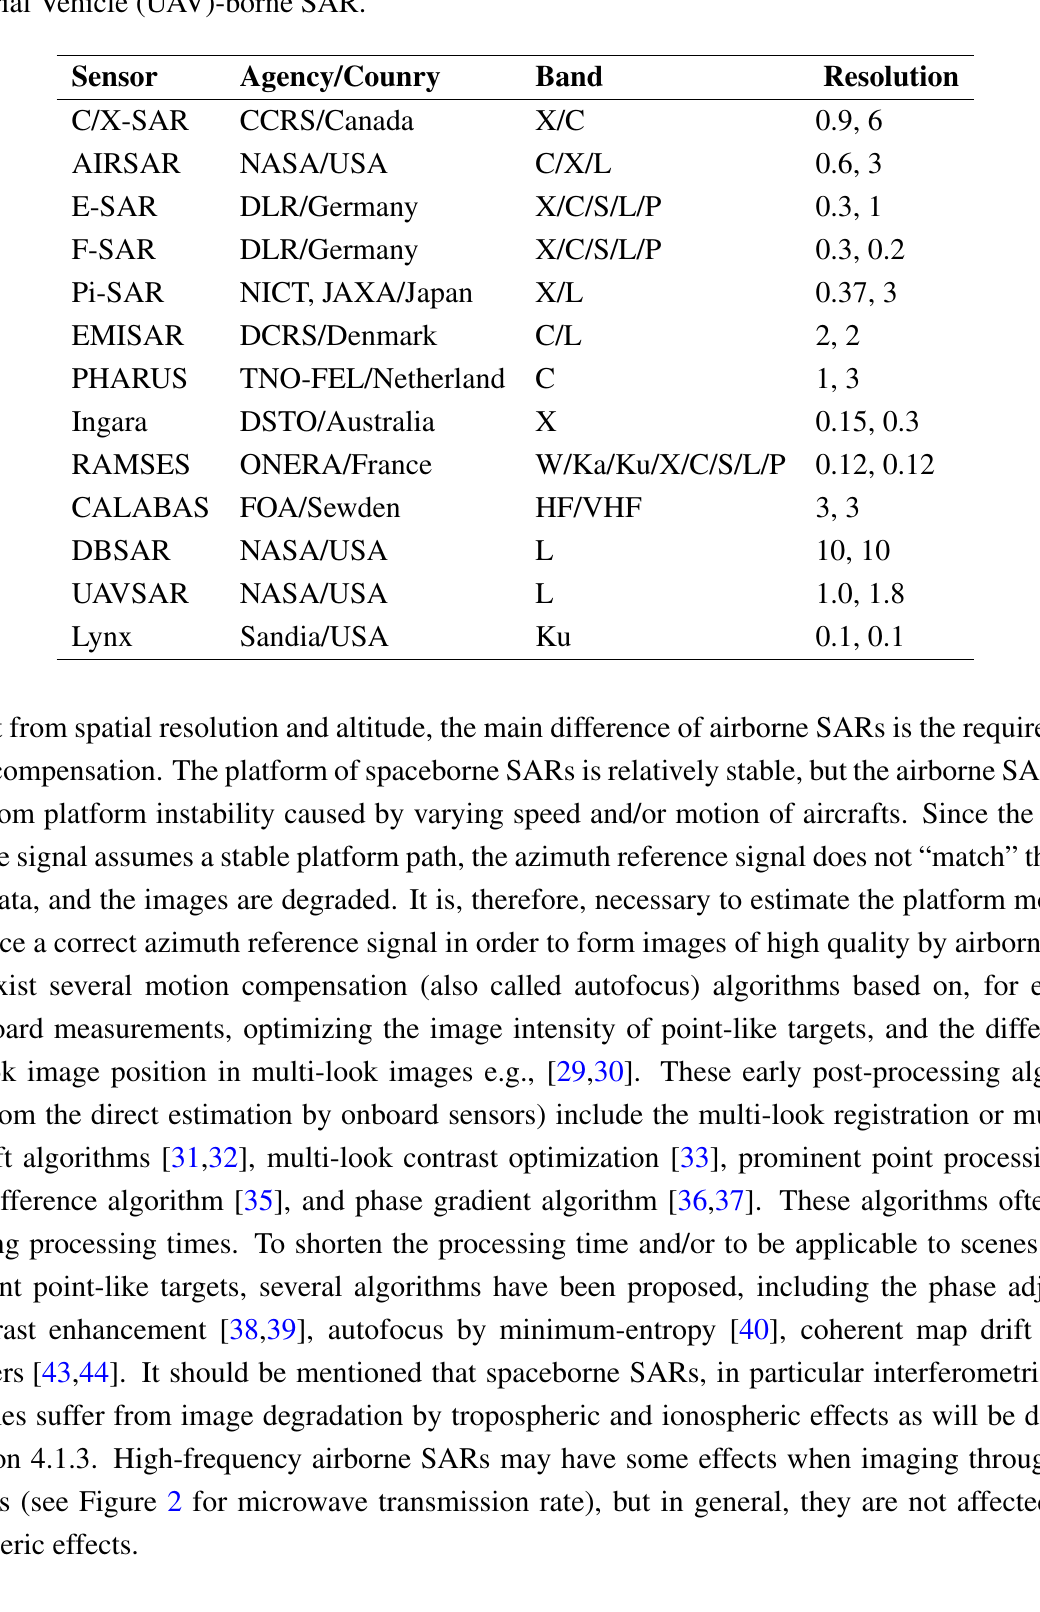
Table 3. Selected airborne SARs. Resolution is the maximum achievable spatial resolution (in general, at highest frequency band) in the unit of meters in the azimuth (single-look) and range directions. Most of the listed airborne SARs can operate in the quad-polarization and interferometric modes, except CALABAS and DBSAR. Lynx is an Unmanned/Uninhabited Arial Vehicle (UAV)-borne